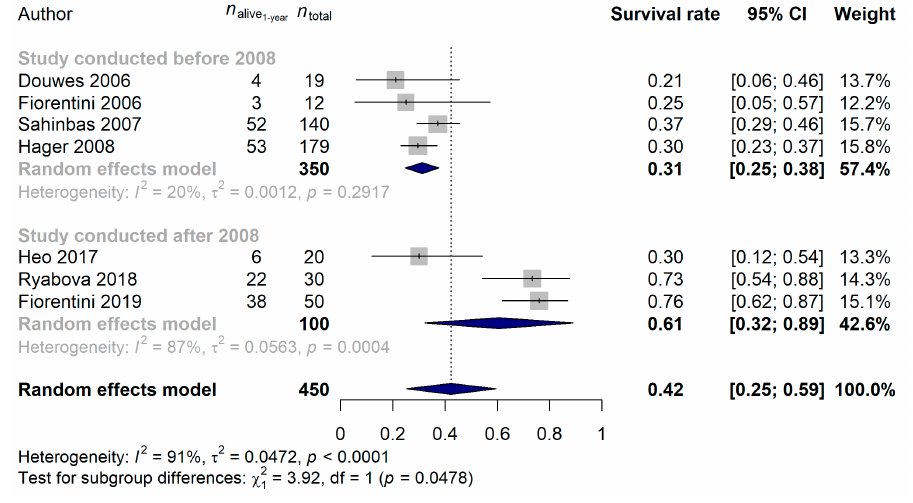
Figure 3. Effect of modulated electro-hyperthermia on 1-year glioblastoma survival rate, grouped by studies published before and after 2008 [43,46–51].